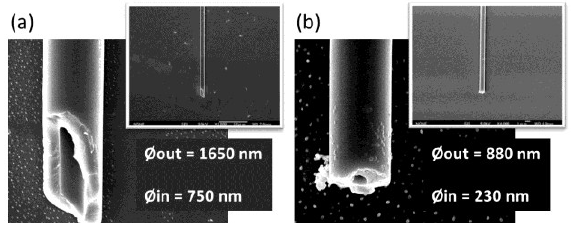
Fig. 2. Scanning electron microscopy images of two broken tapered glass capillaries of different sizes.